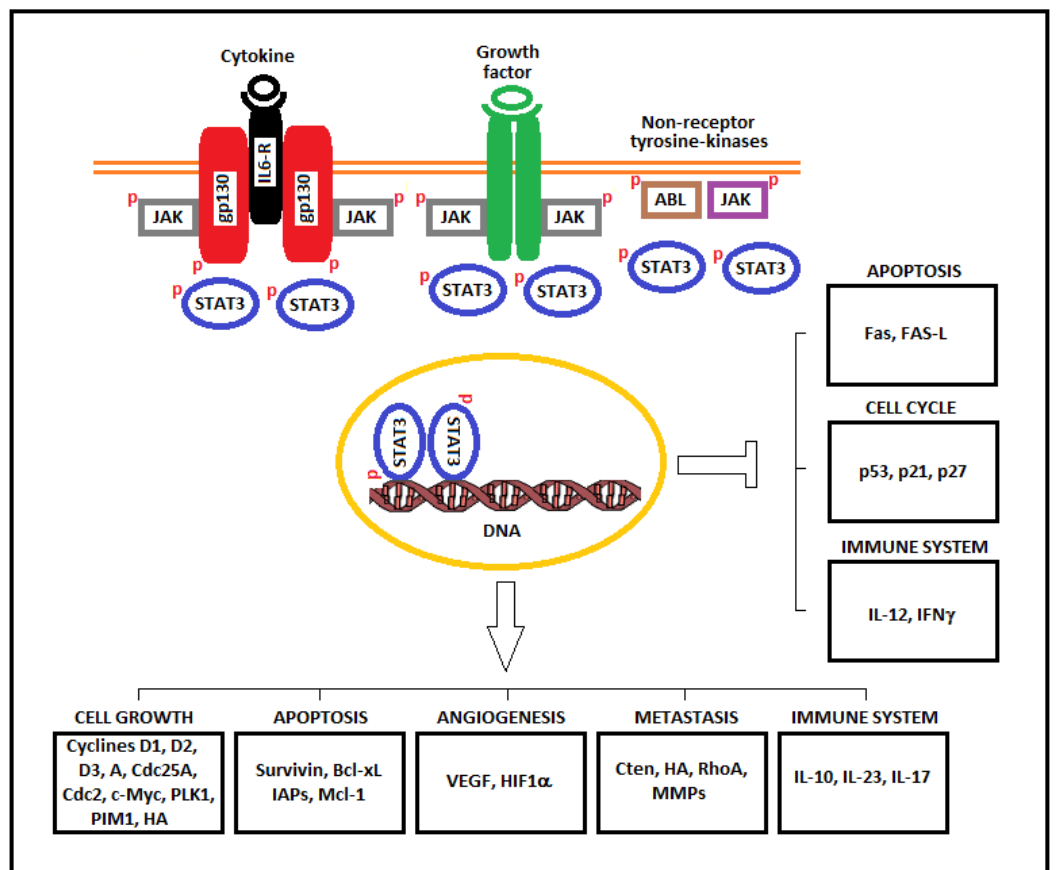
Figure 2. STAT3 upregulation and downregulation of factors involved in cell growth, apoptosis, angiogenesis, invasion, metastasis, and the immune system. STAT3 is activated through the interaction of cytokines and growth factors. Non-receptor tyrosine kinases have intrinsic kinase activity, whereas the receptors of ligands have associated JAK, which, when phosphorylated, acts as a platform for un-phosphorylated STAT3 to become activated. Phosphorylated STAT3 dimers translocate to the nucleus where they upregulate and downregulate a variety of genes that can contribute to tumorigenesis.